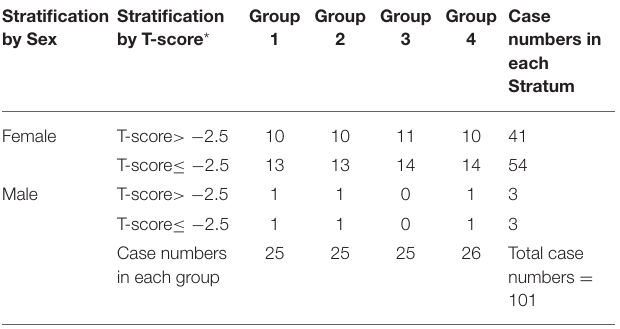
TABLE 2 | The results of randomization to the four groups from the four Strata. Stratification by Sex